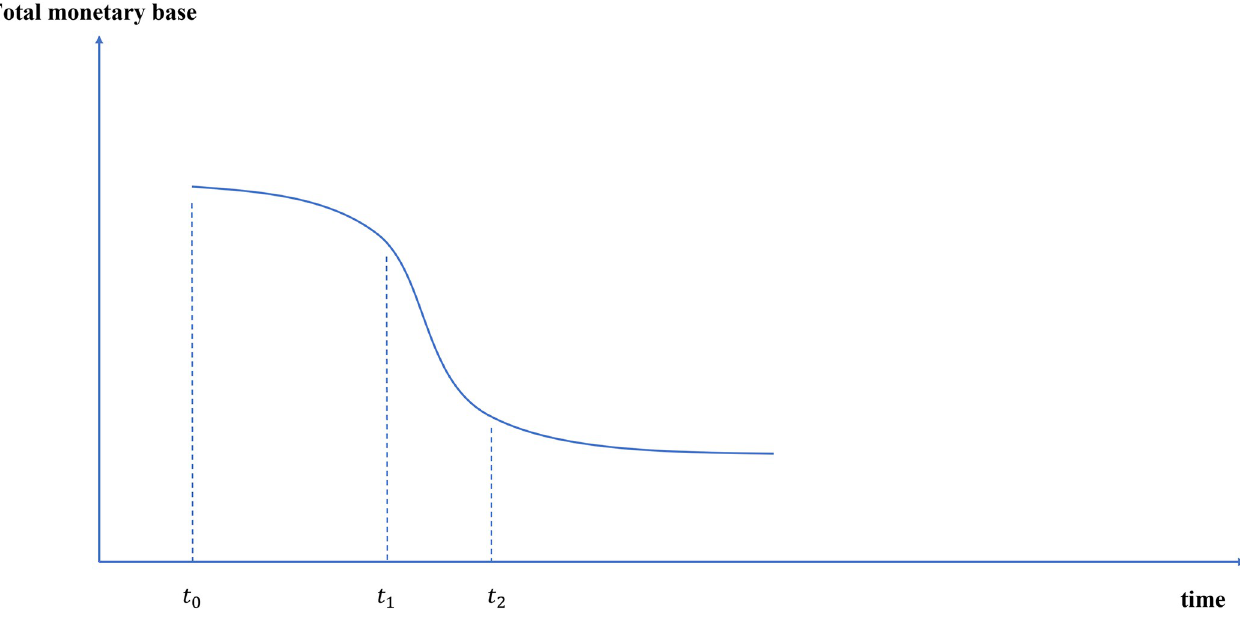
Fig 9. Path changes of monetary base after e-CNY